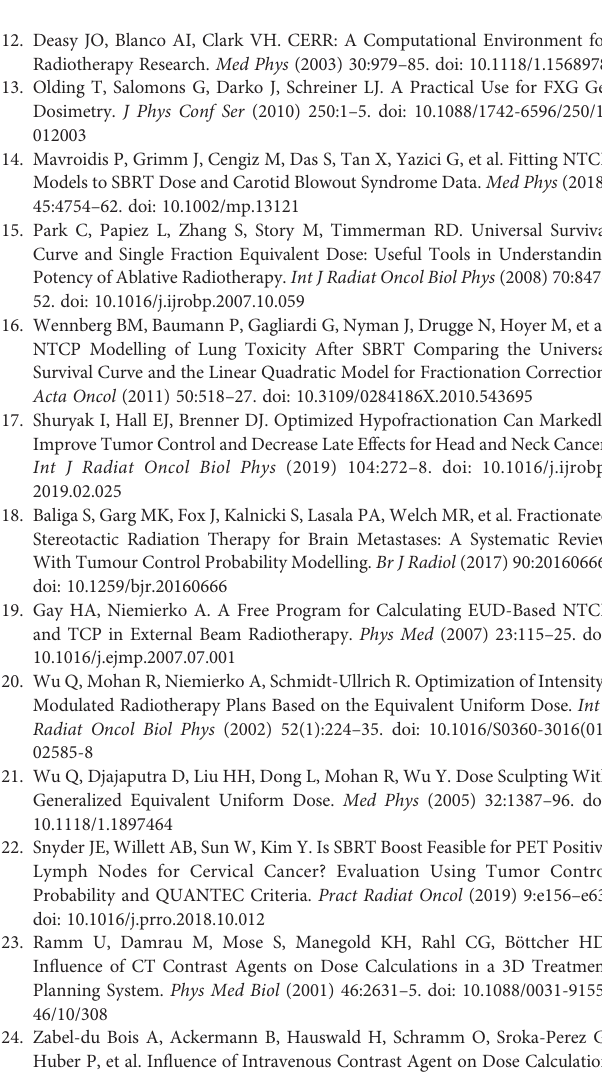
Supplementary Figure 1 | The schematic plot of inhomo-case de fi nition. (A) Coronal and (B) sagittal direction of generic anatomy showing the approximate path of each beam. Supplementary Figure 2 | The schematic plot of homo-case de fi nition. (A) Coronal and (B) sagittal direction of generic anatomy showing the approximate path of each beam. The colorspink, green, and aqua represented the tumor, cavity, and beam, respectively. Supplementary Appendix A | The target gamma difference for each